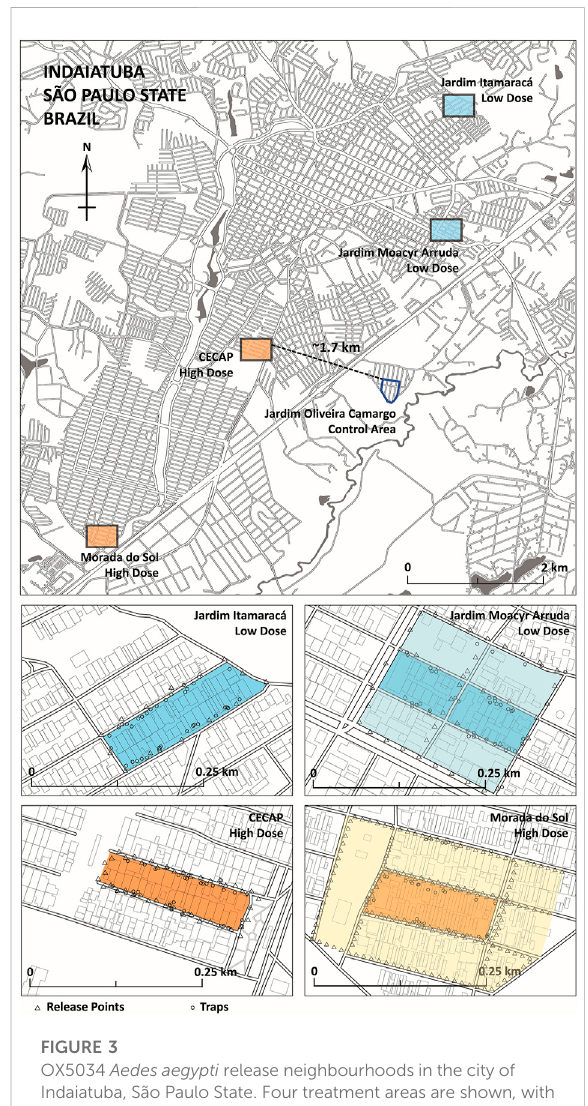
FIGURE 3 OX5034 Aedes aegypti release neighbourhoods in the city of Indaiatuba, São Paulo State. Four treatment areas are shown, with blue shading indicating low-dose treatment areas (Jardim Itamaracá and Jardim Moacyr Arruda), and orange shading indicatinghigh-dosetreatmentareas(CECAP,MoradadoSol).The control area (Jardim Oliveira Camargo) is shown with a dark blue outline. The geographic coordinates of the city are 23 ° 05 ′ 24 ″ S and 47 ° 13 ′ 04 ″ W. Release points (triangles) and trap locations (smallcircles)areshownineachofthefourtreatmentareas.Buffer zones (deployed from February 2019) are shown for Jardim Moacyr Arruda (pale blueshading) and Morada do Sol (pale orange